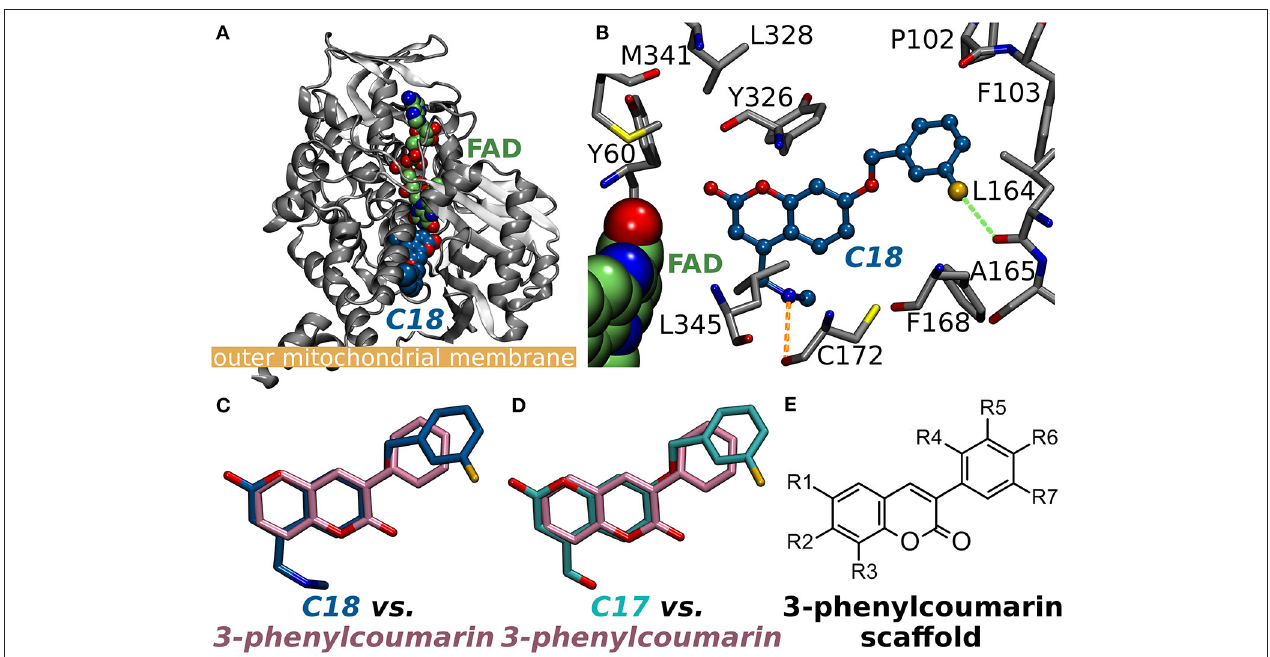
FIGURE 1 | Monoamine oxidase B structure and the small-molecule inhibitors. (A) The cytoplasmic MAO-B monomer (gray cartoon; PDB: 2V61; A-chain) (Binda et al., 2007) is anchored by its C-terminal helix onto the outer mitochondrial membrane [thick orange line; from the OPM database (Lomize et al., 2006)]. The bound inhibitor 7-(3-chlorobenzyloxy)-4-(methylamino)methyl-coumarin ( C18 in PDB: 2V61; blue backbone) and the cofactor flavin adenine dinucleotide (FAD; green backbone) are shown as CPK models. (B) A close up of the MAO-B active site with C18 (blue backbone; ball-and-stick model) shows the small-molecule forming a halogen bond (green dotted line) and an H-bond (orange dotted line) with the main chain oxygen atoms of Leu164 and Cys172 (ball-and-stick models with gray backbone), respectively. The binding poses of the coumarin-based inhibitors (C) C18 and (D) 7-(3-chlorobenzyloxy)-4-carboxaldehyde-coumarin ( C17 in PDB: 2V60) ( Binda et al., 2007) are highly similar with the 3-phenylcoumarin scaffold pose produced by molecular docking. Notably, the coumarin ring is reversed for the established inhibitors in comparison to the docking-based pose of the scaffold. Moreover, the phenyl rings of C17 and C18 are attached via ether bonds to the coumarin’s C7-position instead of C3-position used with the inhibitors introduced in this study. (E) The 2D structure of the 3-phenylcoumarin scaffold indicating the positions of the functional R1-R7